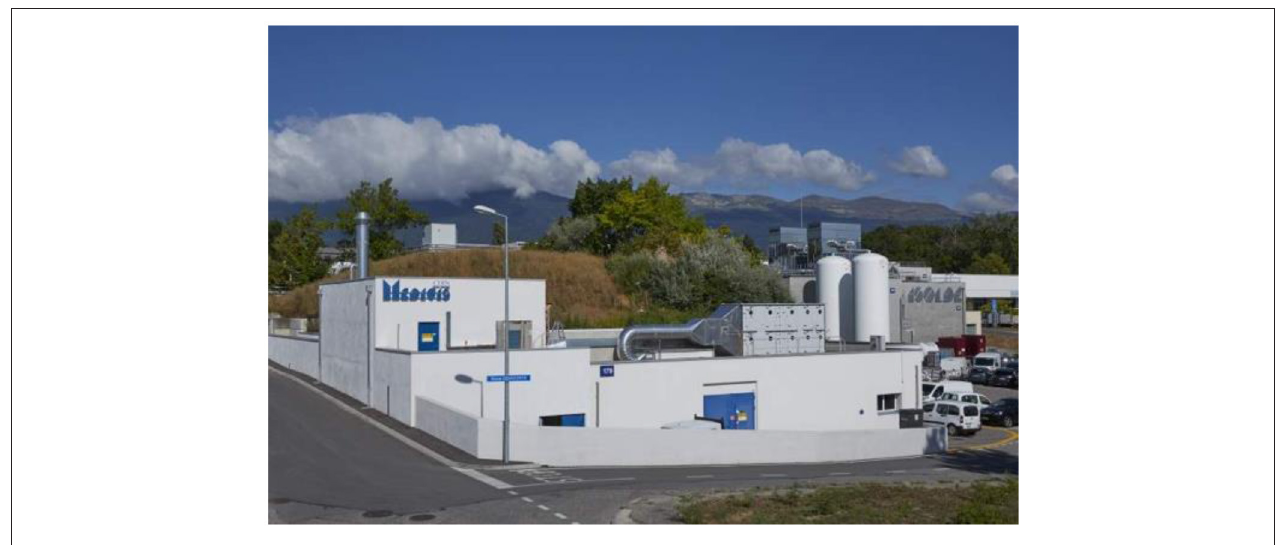
FIGURE 1 | The CERN-MEDICIS building completed in 2017.